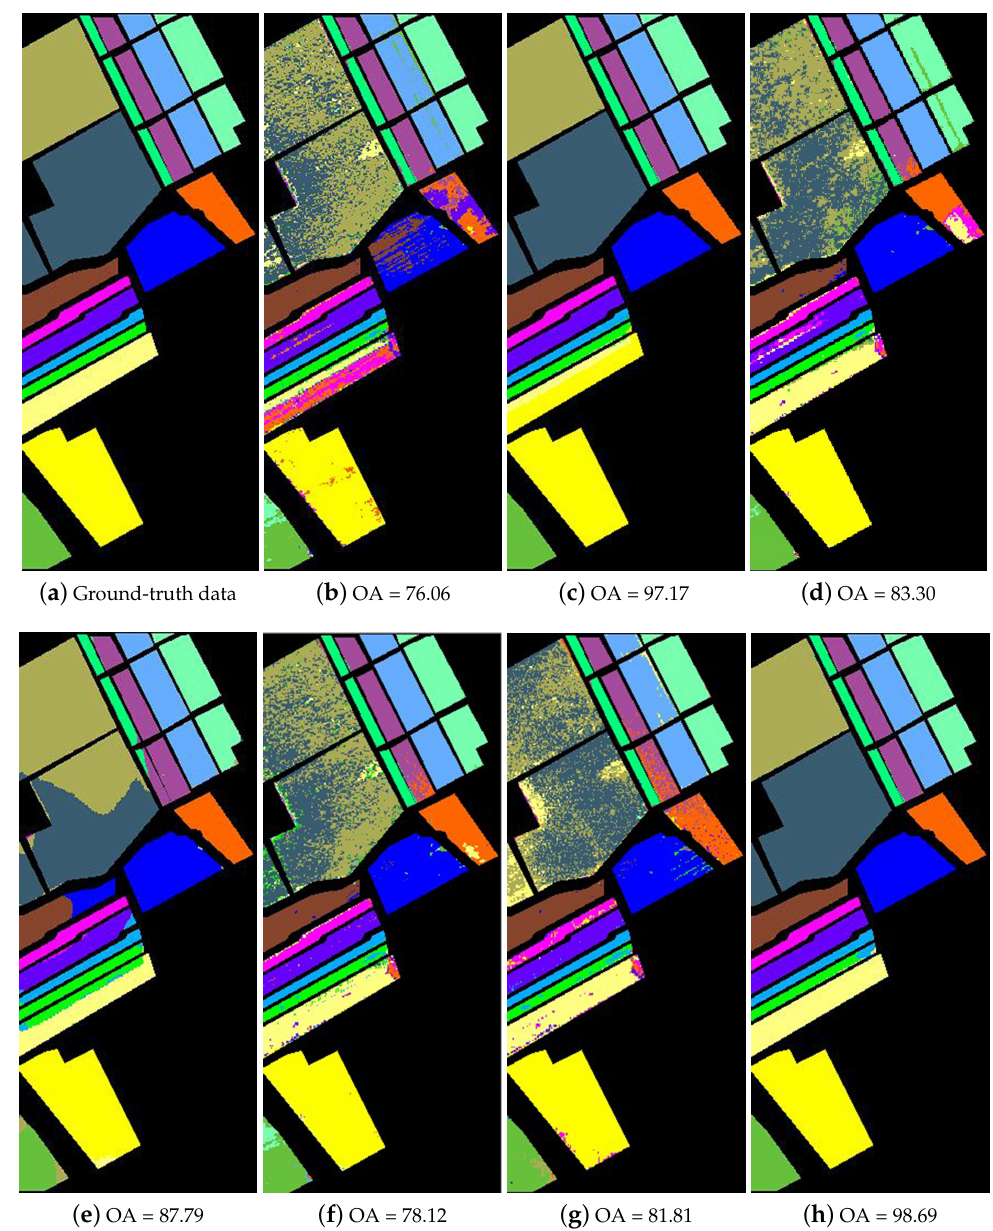
Figure 12. The classification maps of different methods for the Salinas image. ( a ) ground-truth data; ( b ) SVM; ( c ) ERW; ( d ) SSLP-SVM; ( e ) MPM-LBP; ( f ) R-2D-CNN; ( g ) CasRNN; ( h )